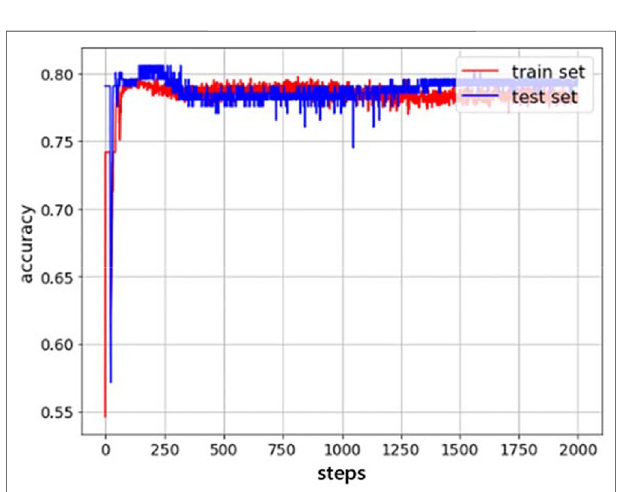
FIGURE 9 | The rate of success in the training process of the soft